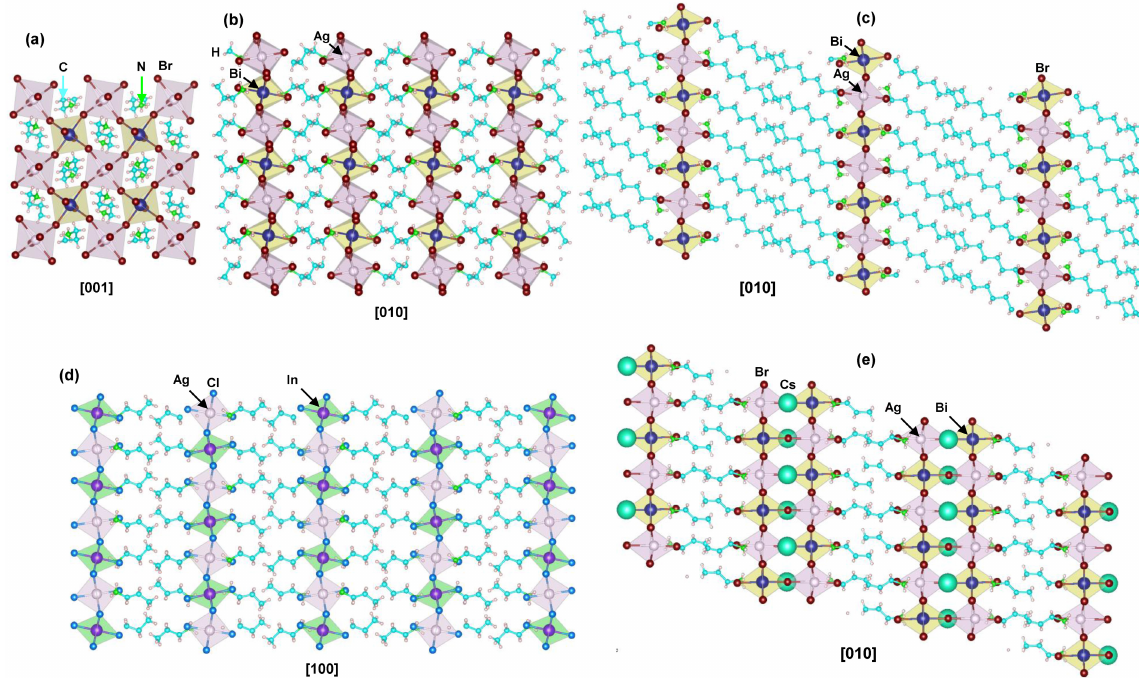
Figure 38: Structural models of (a, b) (NH 3 (CH 2 ) 4 NH 3 ) 2 AgBiBr 8 , (c) (CH 3 (CH 2 ) 7 NH 3 ) 4 AgBiBr 8 , (d) (CH 3 (CH 2 ) 2 NH 3 ) 4 AgInCl 8 , and (e) (CH 3 (CH 2 ) 2 NH 3 ) 2 CsAgBiBr 7 with 2-dimensional double perovskite